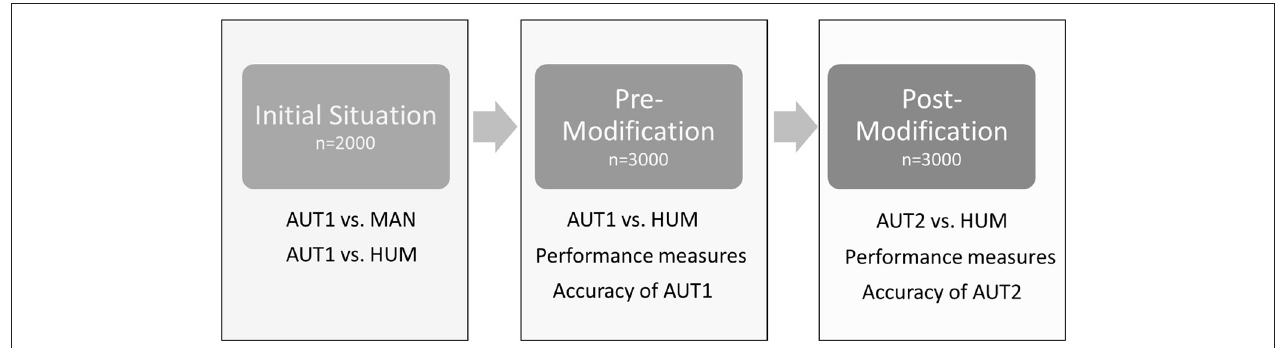
FIGURE 1 | Outline of the different steps of the study. AUT1: algorithm for automated detection pre-modification; AUT2: algorithm for automated detection post-modification; MAN: scoring of footpad dermatitis by a human observer based on the actual tangible foot; HUM: scoring of footpad dermatitis by a human observer based on digital pictures produced by the automatic